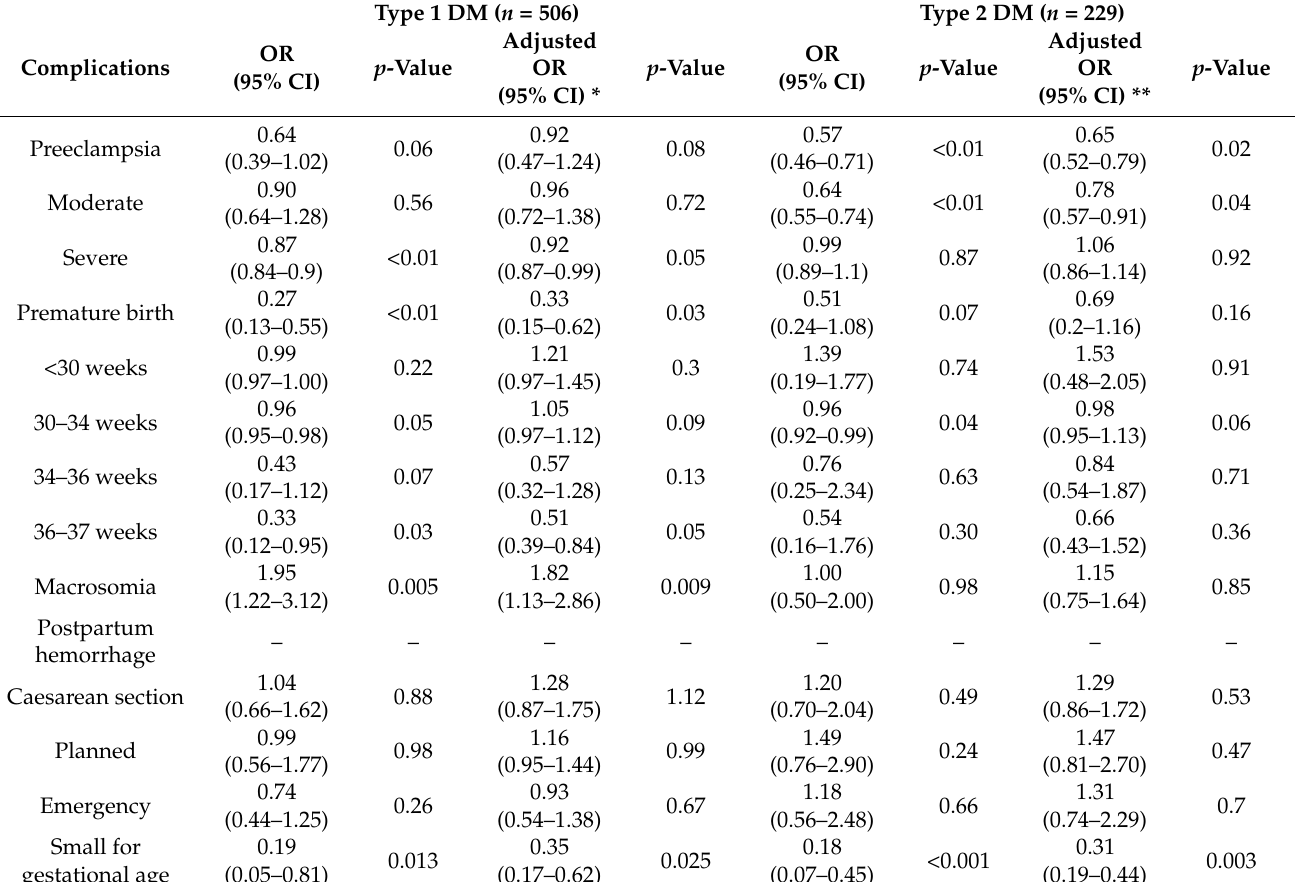
Table 3. Effect of acetylsalicylic acid intake on pregnancy outcomes.